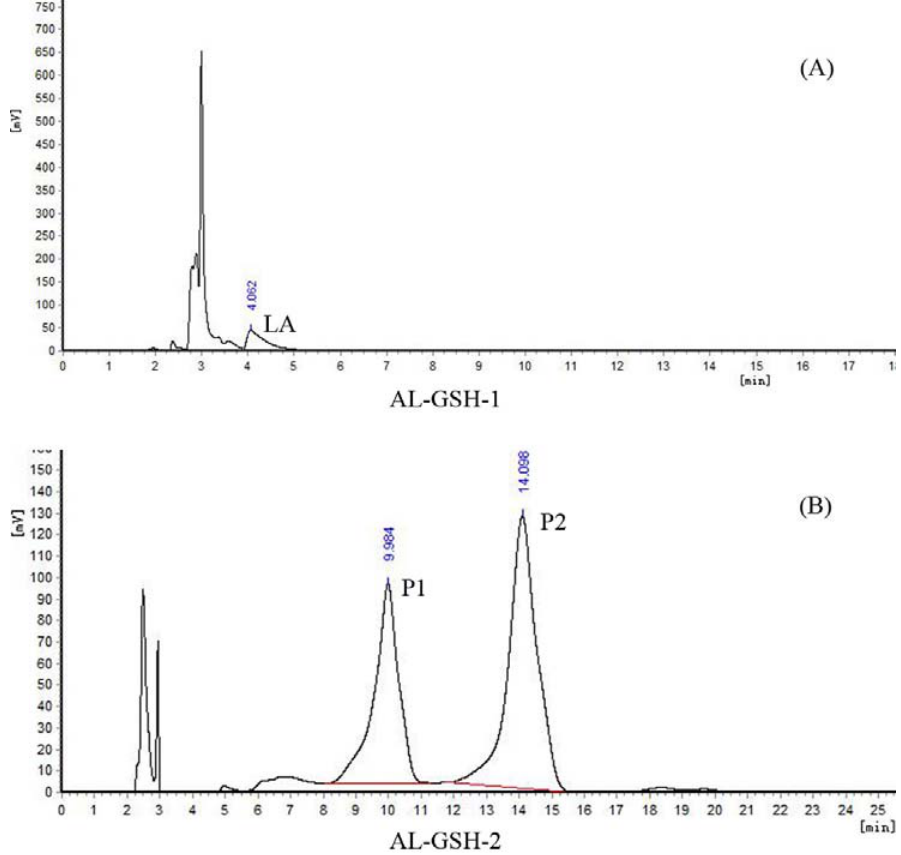
Figure 4. HPLC chromatograms of the reaction mixture of AL-1 and GSH. AL-GSH-1 was analyzed by the mobile phase (1) methanol and water (52:48, v/v). AL-GSH-2 was analyzed by the mobile phase (2) methanol and 0.1% v/v TFA solution (40:60,